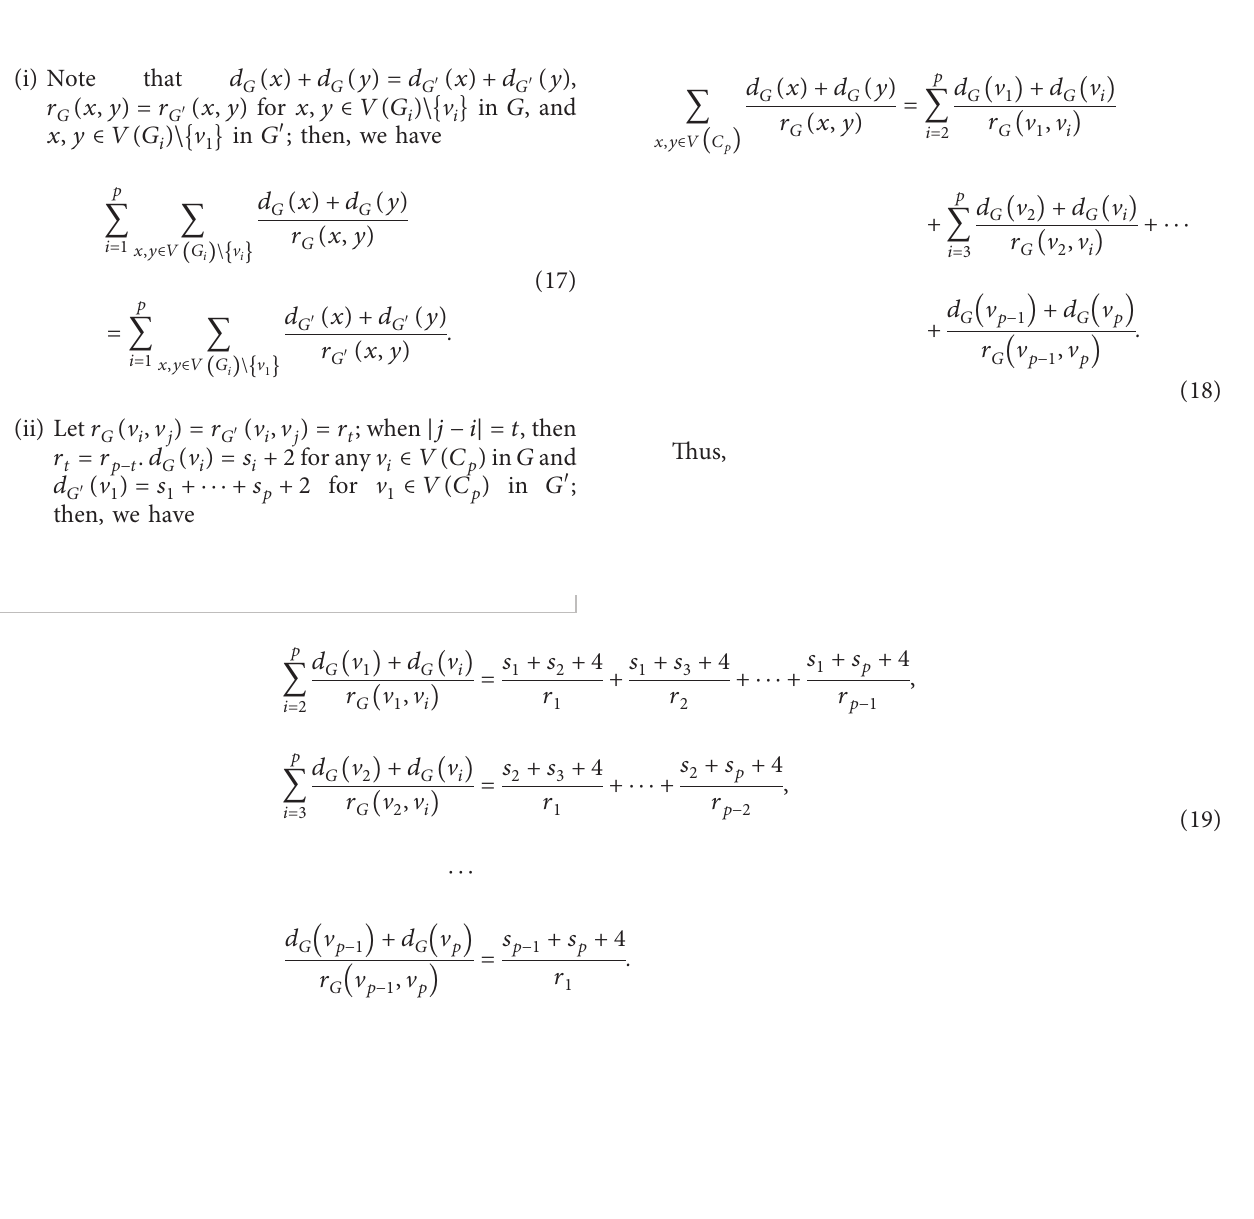
Figure 2: The cycle-lifting transformation. (a) G . (b) G ′